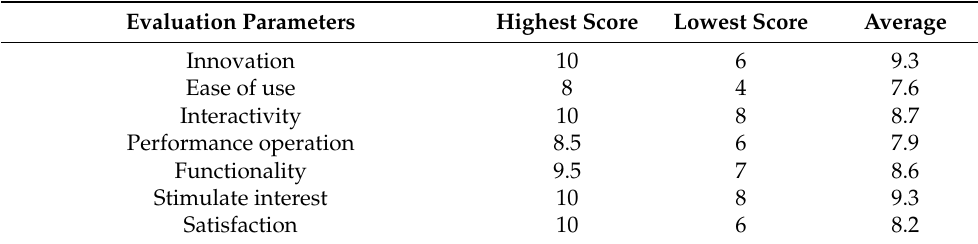
Table 3. Statistical results of the user experience (full score is 10